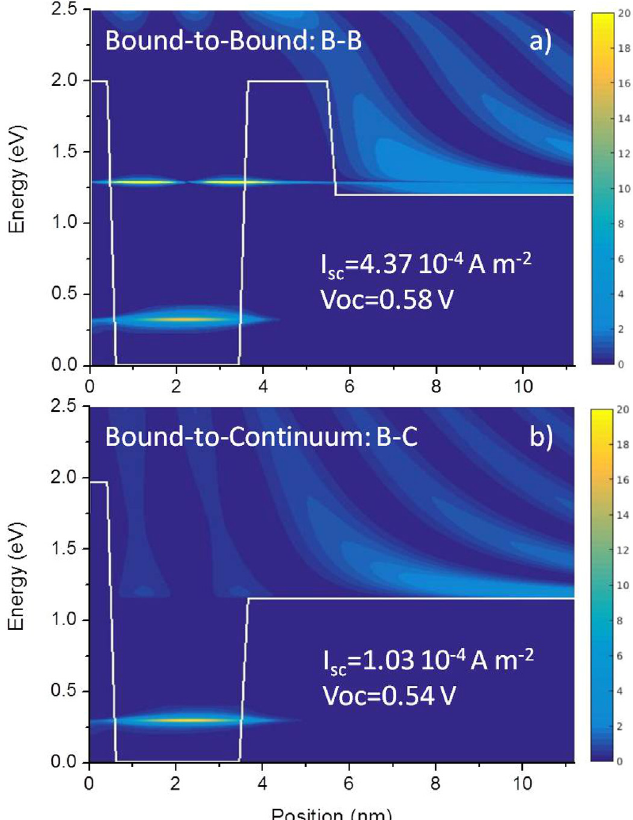
Fig. 2. The band-diagram (white line) and the local-DOS of electrons in (a) the bound-to-bound system and in (b) the bound-to- continuum system. In a corresponding bound-to-bound IBSC the reduction of voltage due to the presence of the IB should be 1 – 0.58 =0.42 V against 1 – 0.54 =0.46 V for the bound-to-continuum con fi